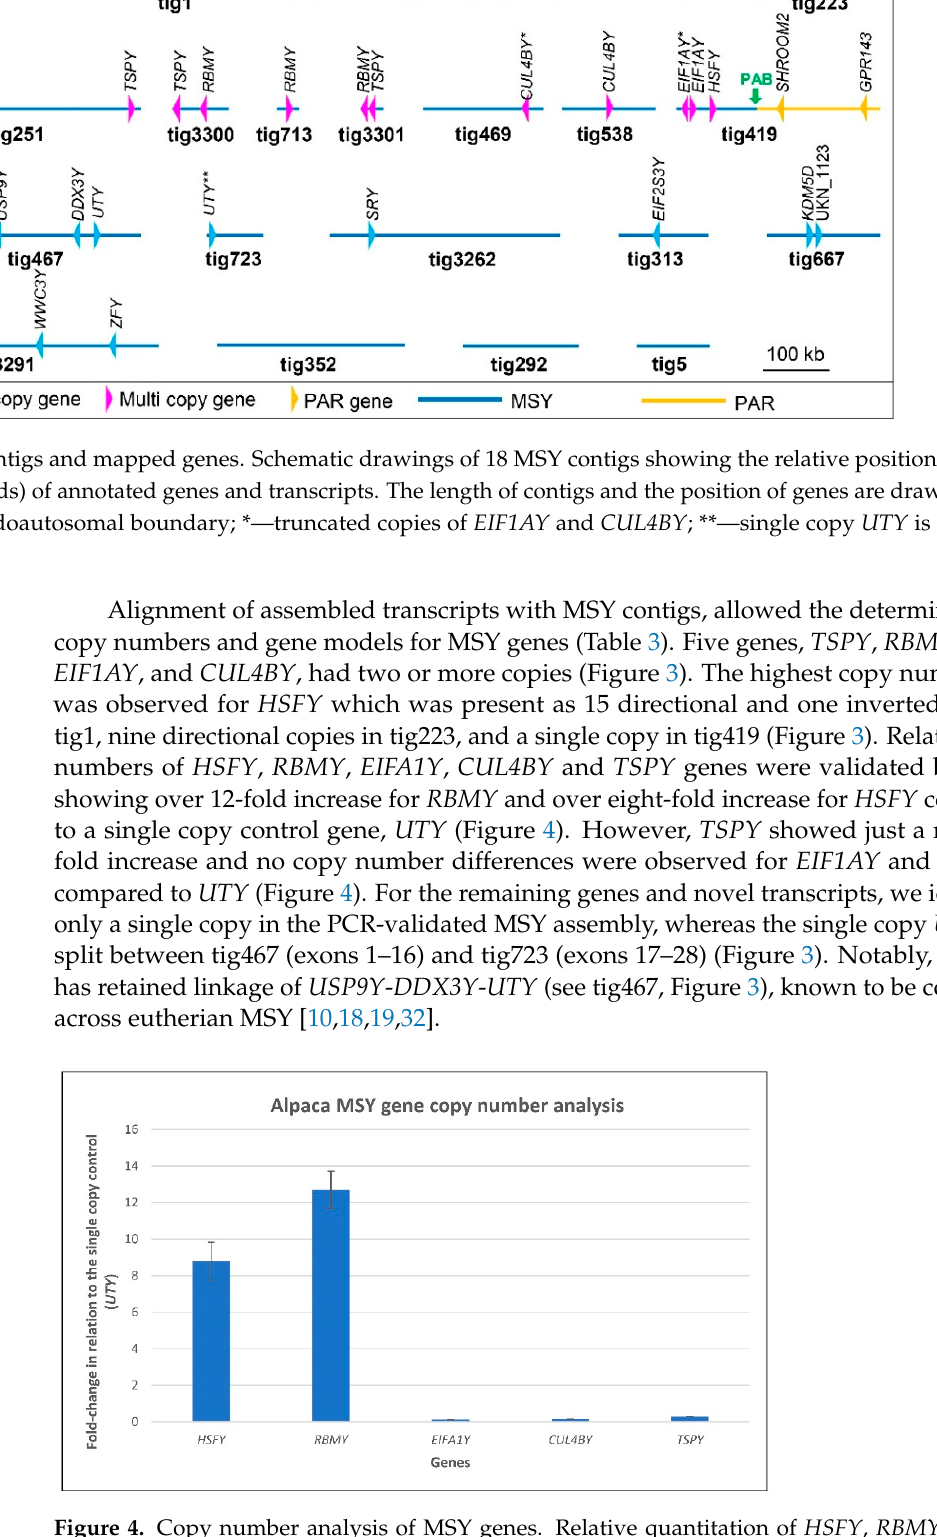
Figure 4. Copy number analysis of MSY genes. Relative quantitation of HSFY , RBMY , EIF1AY , CUL4BY , and TSPY (x-axis) copy numbers in relation to UTY as a single copy control (fold change; y-axis); vertical black bars at the top of fold-change columns denote standard deviation. Gene models were determined for all single copy genes and individual copies of multi copy genes (Table 3), except for AMELY . This was because AMELY has very low or Instead, it was annotated using human, cattle, pig, and goat AMELY transcripts. The re- sulting alignments allowed to recognize the location of the gene in tig3291 but were not sufficient for determining its exon-intron structure (Table 3). Among multi copy genes, individual copies of HSFY , TSPY , and RBMY had the same exon-intron structure and were considered complete. However, we observed additional short (<200 bp) sequences with homology to RBMY , likely representing incompletely assembled copies or pseudogenes. Furthermore, EIF1AY had one full copy with seven exons and another, truncated and in- verted copy with exons 1–4, both in tig419 (Figure 3), suggesting the presence of a trun- cated pseudogene or error in the assembly. Similarly, CUL4BY appeared as one full copy with 8 exons in tig538 and as short sequences homologous to CULB4Y in tig469 . The gene models were further validated by PCR with primers designed from predicted exons (Ta- ble S1) and in most cases male-specific PCR products of expected size were observed (Fig- ure S3). The exception was DDX3Y , where primers amplified male-specific but a larger product than expected, suggesting incorrect assembly or an error in determining exon- intron structure.